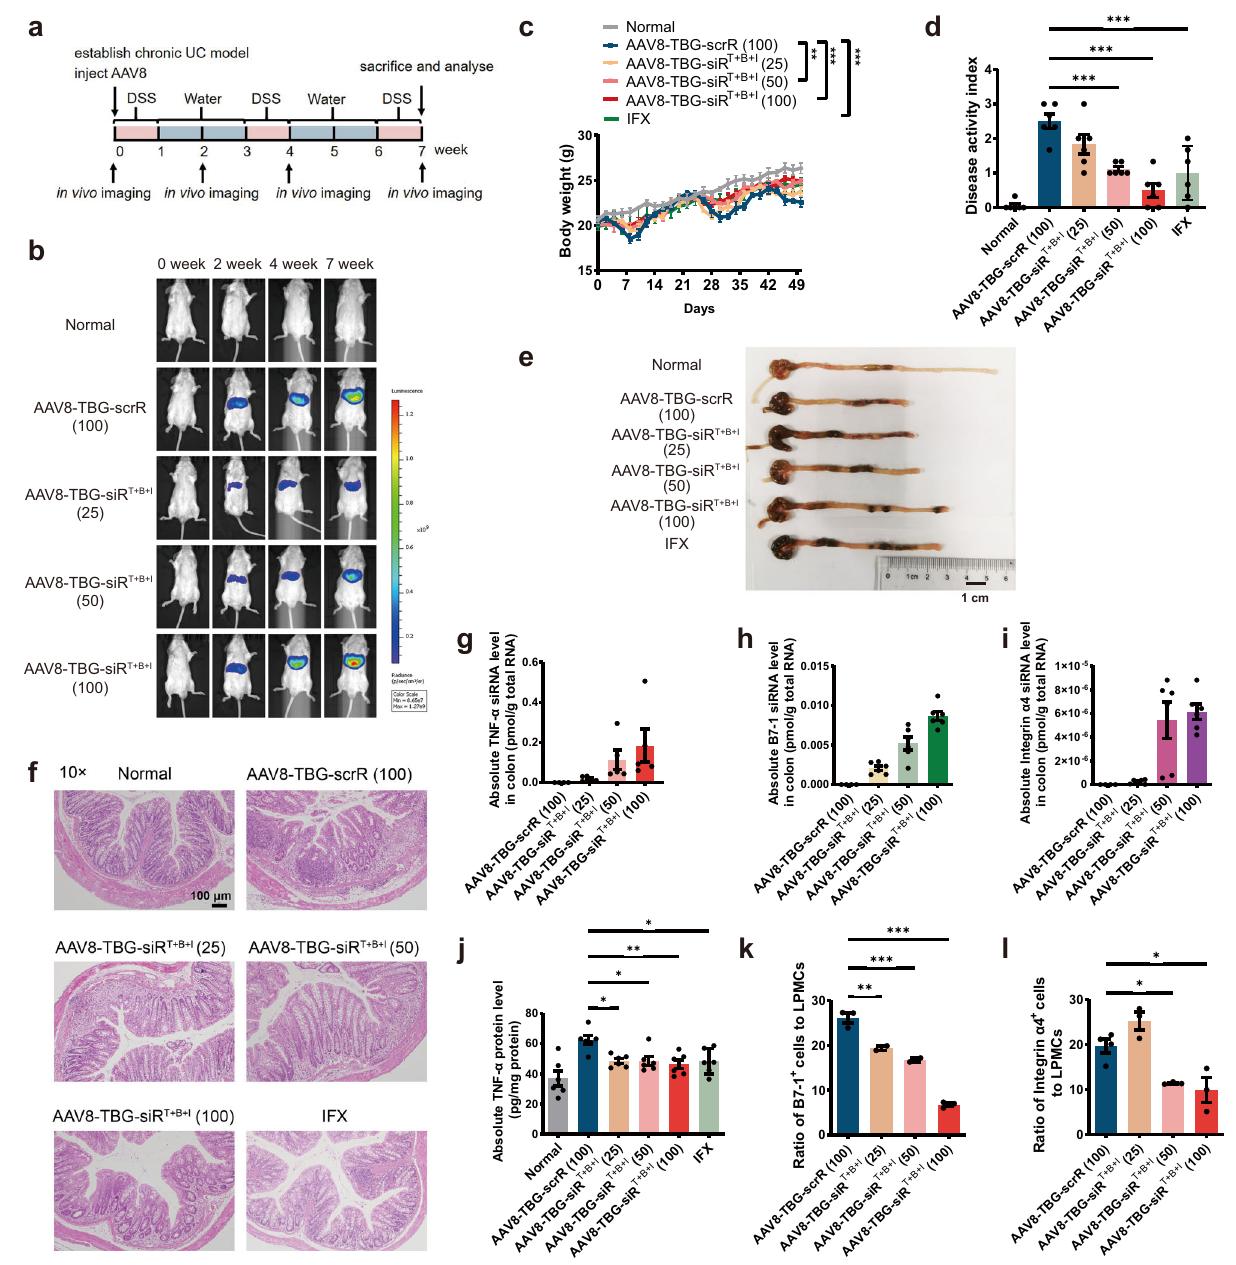
Fig. 10 | Intravenous injection of the AAV8-TBG-siR T+B+I induces long-term combinationtherapy in the DSS-inducedchronic UCmodel. a Flowchart ofthe experimentaldesign. b EvaluationofAAV-mediatedluciferaseexpressiontore fl ect co-expressed siRNA accumulation in vivo ( n =6 in each group). c Body weight curves ( n =6 in each group). d DAI scores ( n =6 in each group). e Representative macroscopic features of colons. Scale bar: 1cm. f Representative images of H&E staining of colon sections. Scale bar: 100 μ m. Each H&E staining was repeated independently three times, and representative images are shown. g – i Quantitative RT-PCR analysis of the absolute expression levels of TNF- α siRNA, B7-1 siRNA and